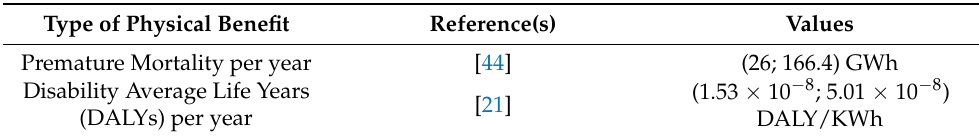
Table 9. Relative physical benefits (source: own